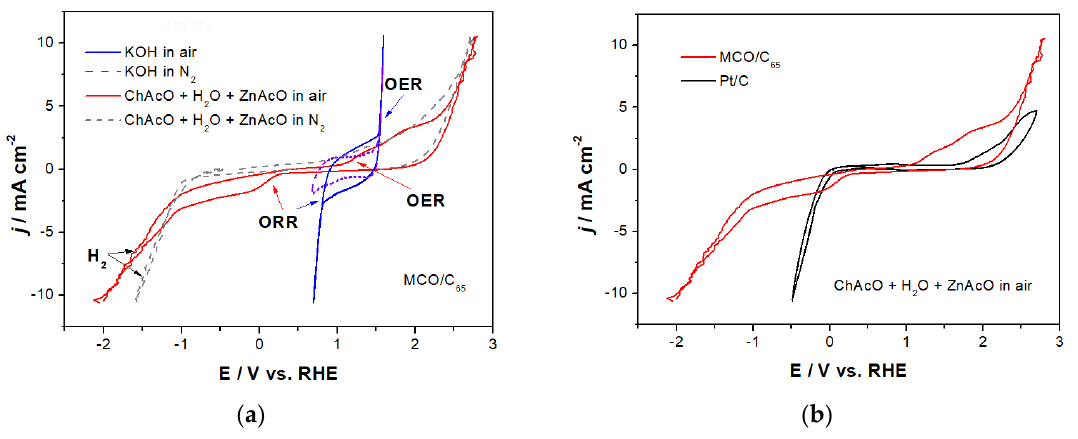
Figure 8. ( a ) OER / ORR activity of MCO in ChAcO + 30 wt.% H 2 O electrolyte at 10 mV s − 1 with dry synthetic air. CVs in 7 M KOH electrolyte are shown for comparison. ( b ) Overlay of OER / ORR measurements at MCO and Pt in ChAcO + 30 wt.% H 2 O + 0.01 M ZnAcO.